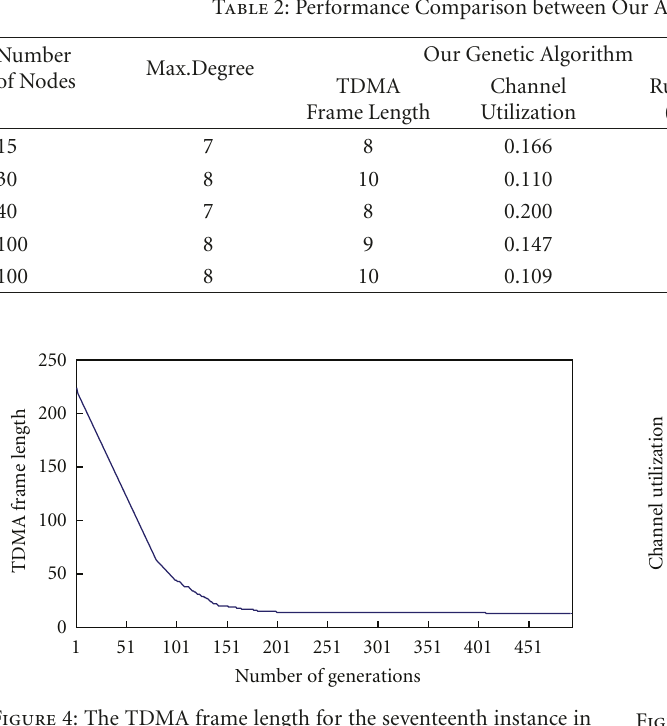
Figure 5: Channel utilization for the seventeenth instance in Table 3.